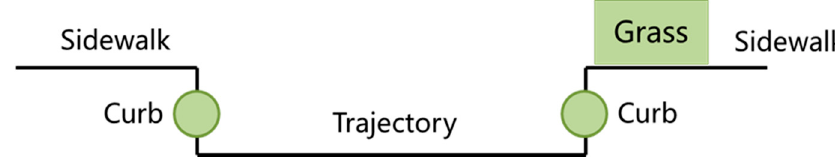
Figure 6. Road information relations between the sidewalk and the motorway.